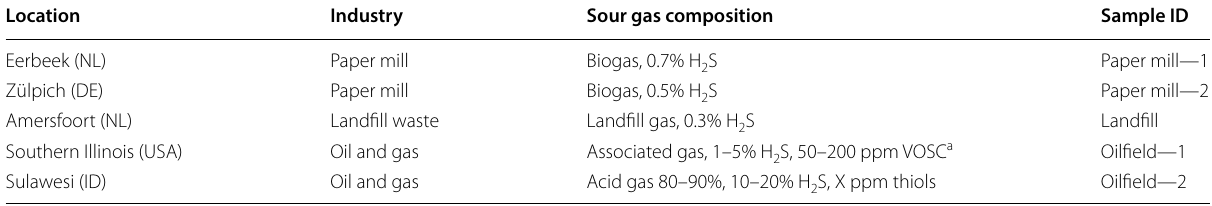
a VOSC—volatile organic sulfur compounds, e.g., thiols and